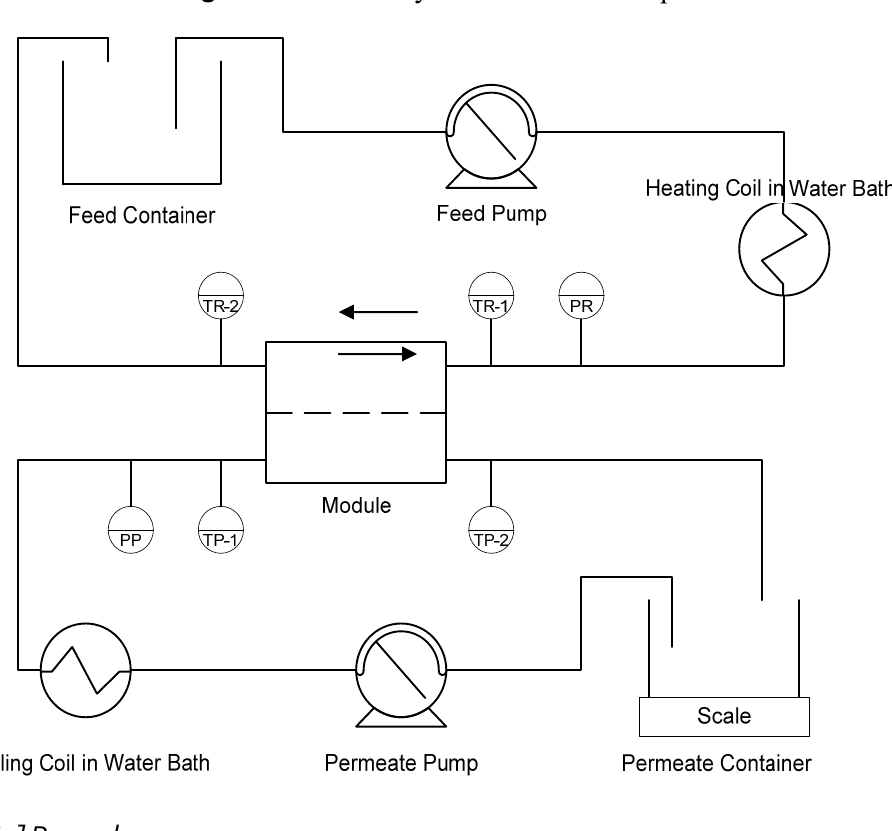
Figure 3. Laboratory scale DCMD